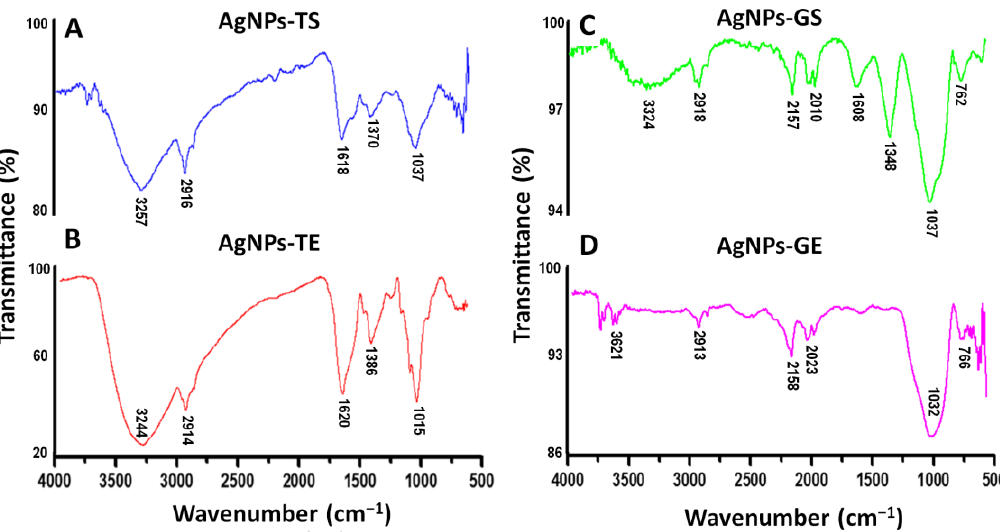
Figure 6. FTIR spectra of synthesized AgNPs. ( A , B ) AgNPs synthesized using the supernatant (TS) and extract (TE) of T. harzianum , respectively, ( C , D ) AgNPs synthesized using the supernatant (GS) and extract (GE) of G. sessile , respectively.